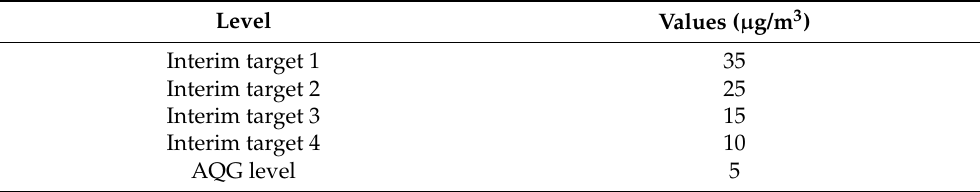
Table 1. Recommended AQG level and interim targets of PM 2.5